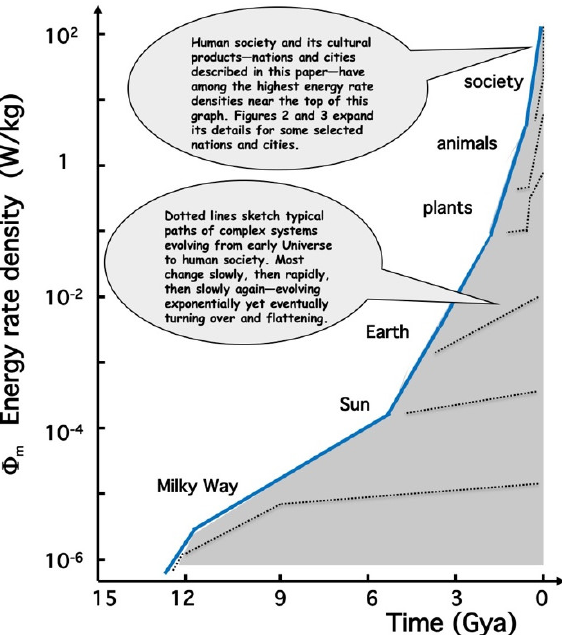
Figure 1. Energy rate densities, Φ m , for a wide array of complex systems that emerged at various times in natural history display a clear trend, implying rising complexity from the big bang at left bottom to human society at top right. The bold blue curve extends vertically and logarithmically over nearly a billion factors of energy, and horizontally and linearly over nearly a quintillion sec- onds of time. Based on recent research and better data, the shape of the bold curve is slightly differ- ent than similar ones published several years ago, e.g., [2,9]. Physical Systems: Galaxies have some of the lowest values of Φ m , not surprisingly since they are among the earliest systems formed in the Universe and most display some of the least ordered structures. From dwarf galaxies to active galaxies, they have values in the range 10 −6 –10 −3 W/kg. Our own galaxy, the Milky Way, for example, now has 10 −5 W/kg, having increased roughly an order of magnitude while changing from primordial blobs to dwarf galaxies (~12 Gya), eventually achieving a merged, mature status (~10 Gya) and its normal state today. Stars range in Φ m from a tenth to a millionth of a W/kg for giants to dwarfs, most of them ~10 −3 W/kg. As they evolve, their values change while undergoing nuclear fusion that enhances interior thermal and chemical gradients, forging ordered layers of heavy elements. The Sun, for example, changes its Φ m from 10 −4 to 10 −2 W/kg while evolving from a young protostar (~5 Gya) to an aged red giant star (~5 Gy in the future). Its current value, as computed above, is 2 × 10 −4 W/kg, and in the far future when its fusion ends, its remains will attain equilibrium as a black cinder with 0 W/kg. Smaller in complexity yet longer in duration, galaxies are nearly as metabolic and adaptive as any life-form, minus any genes, reproduction or inherited traits. They provide chances for energy usage by forming new stars and shredding old stars, all the while ad- justing their lowly order in response to changing galactic environments. Stars, too, have much in common with life; their inward energies and outward wastes undergo slow and steady change, albeit more simply than life. However, no one thinks stars are alive. Most researchers agree stars at least develop and perhaps physically evolve over many